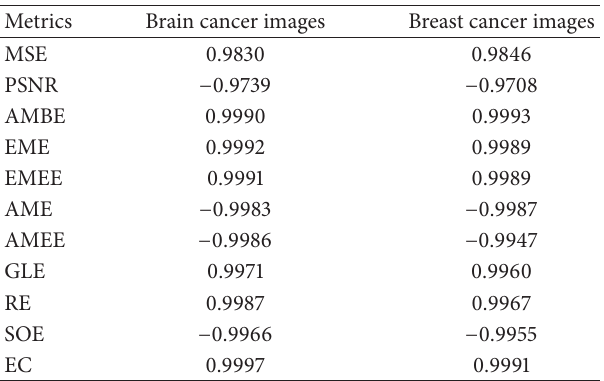
Table 5: Correlation